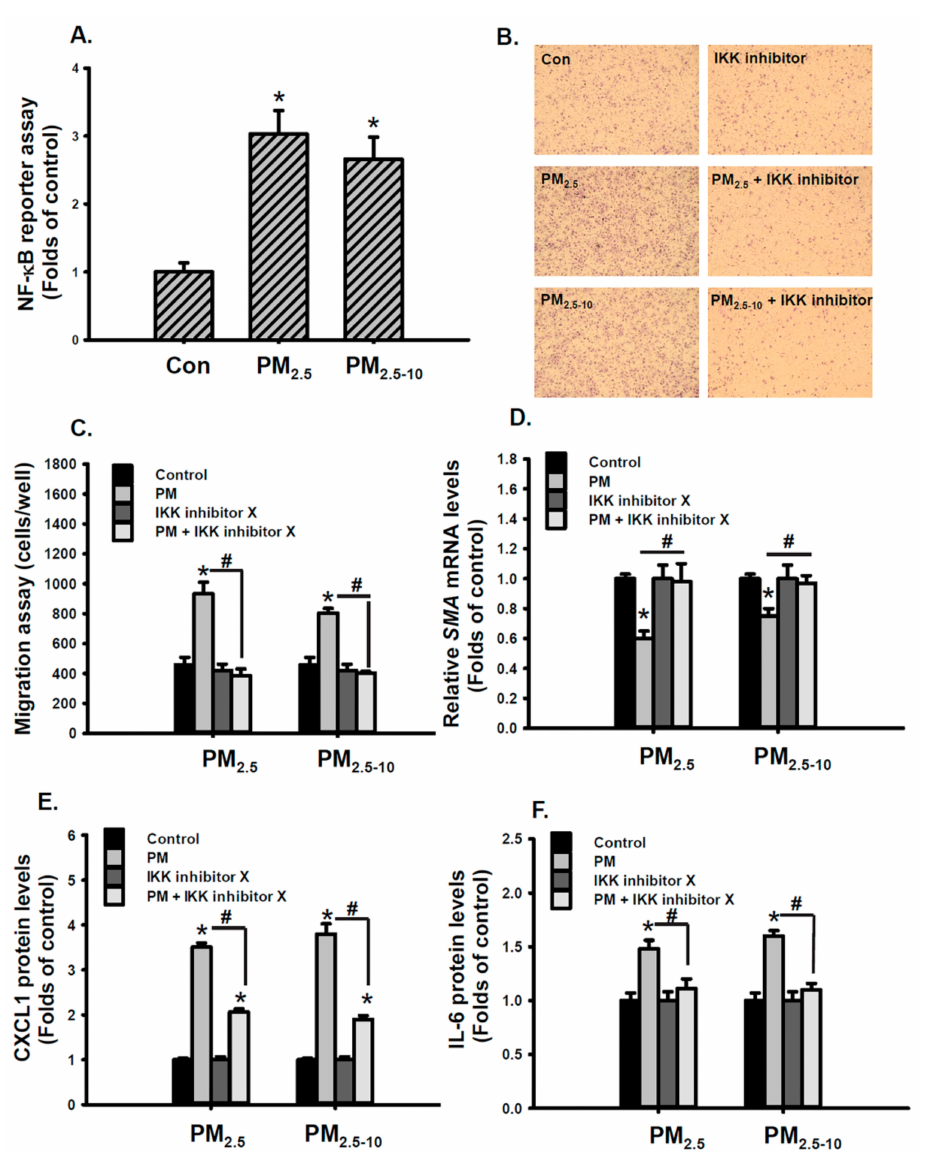
Figure 6. PM 2.5 and PM 2.5-10 induced cell phenotypic changes through the NF- κ B signaling pathway in MVSMCs. MVSMCs were treated with d 2 H 2 O or 25 µ g/mL PM 2.5 or PM 2.5-10 for 48 h. ( A ) NF- κ B reporter activity was measured. MVSMCs were treated with d 2 H 2 O or 25 µ g/mL PM 2.5 or PM 2.5-10 with and without 10 µ M IKK inhibitor for 48 h. ( B ) and ( C ) Migration abilities of MVSMCs were detected and quantified using MetaMorph software. ( D ) The relative SMA mRNA levels were determined using a real-time PCR assay. ( E ) and ( F ) CXCL1 and IL-6 protein concentrations in the media were determined using the enzyme-linked immunosorbent assay. The results are presented as the mean ± SD for three or three independent experiments. * p < 0.05, compared with vehicle-treated cells. # p < 0.05, compared with IKK inhibitor-treated cells. Con: d 2 H 2 O treatment as